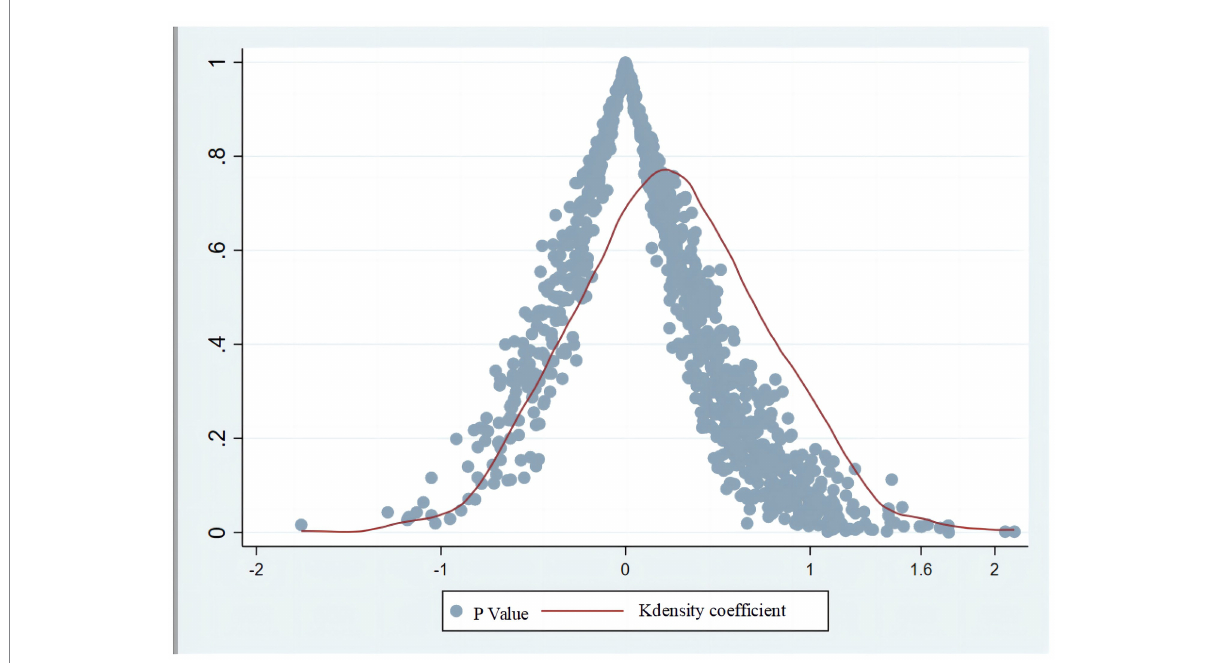
FIGURE 1 Random impact coefficient Kdensity and corresponding p -value.